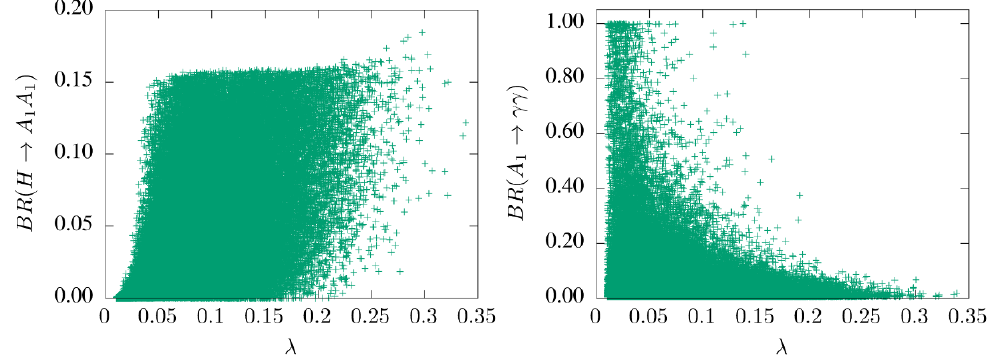
Figure 1 . Allowed regions by all constraints. For details see the